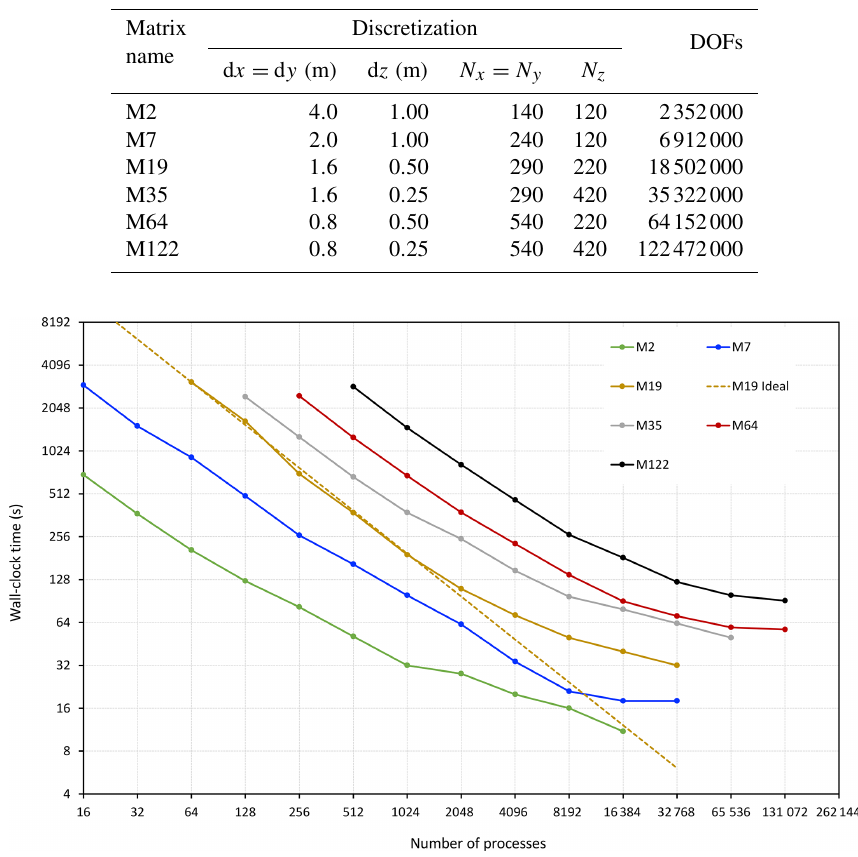
Figure 10. PFLOTRAN scalability for simulating ERT data for the model in Fig. 3 for N e = 128 electrodes. The test is performed on the Theta supercomputer considering six test matrices M2, M7, M19, M35, M64, and M122 with the respective number of DOFs of about 2, 7, 19, 35, 64, and 122 × 10 6 (see Table 1 for